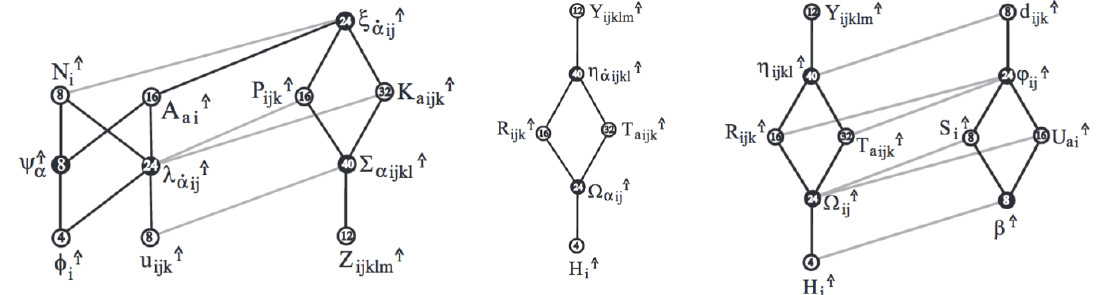
Figure 1 . Adinkra-like representations of three 4D, N = 2